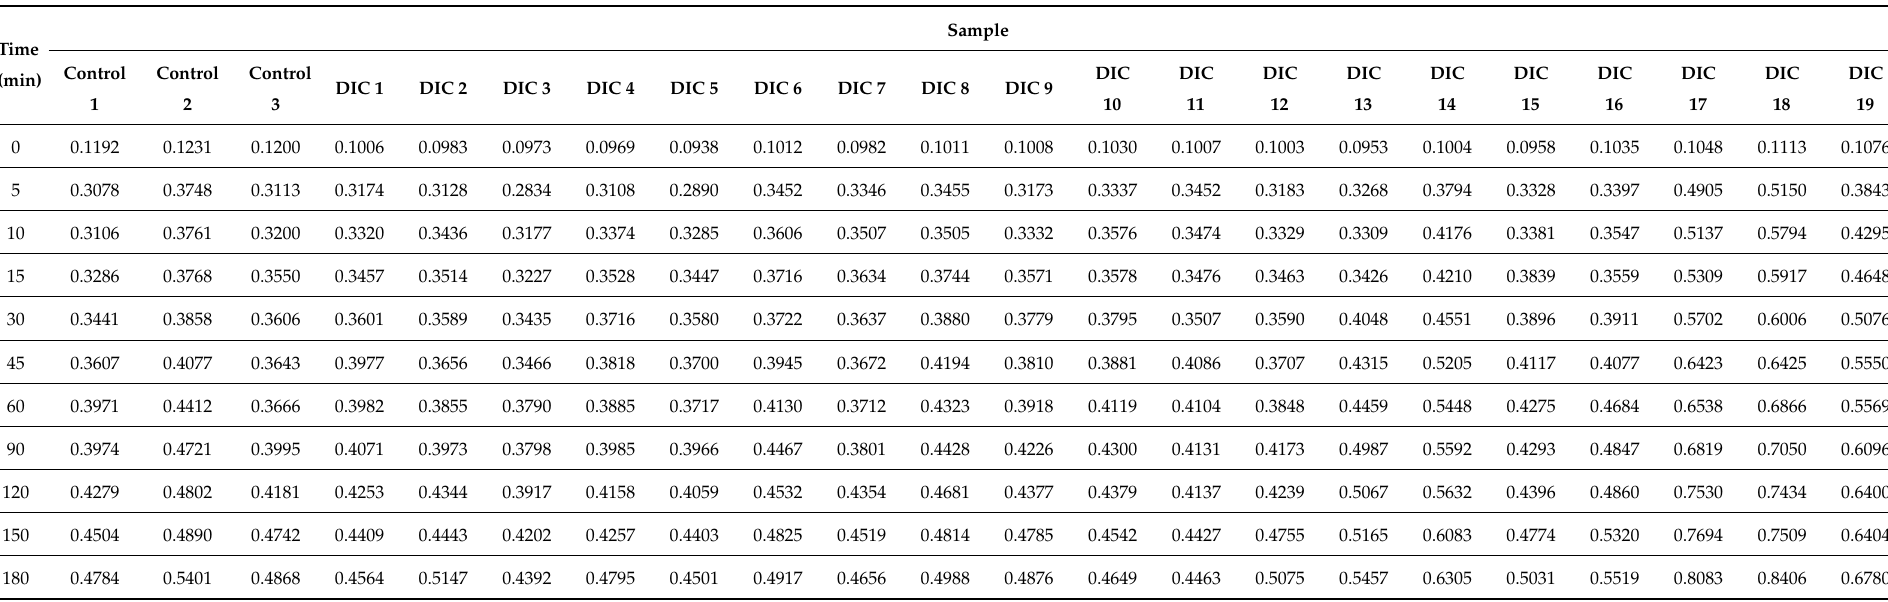
Table 4. Experimental data of the rehydration kinetics of maize kernels. Evolution of moisture content in dry basis (g H 2 O/g dry matter) as a function of the time W =